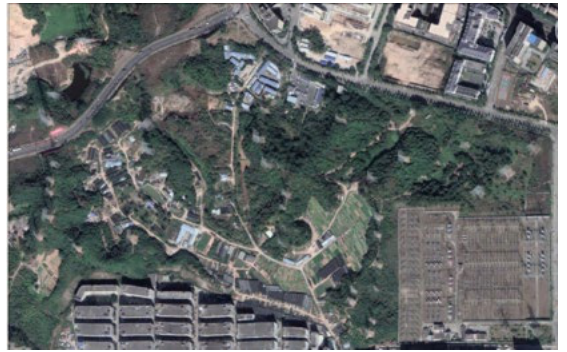
Figure 4. Test site shown in Google Earth The tower has three cross arms, where two transmission lines are combined at each end so that the power line consisting of 12 wires placed at 3 levels, shown in Figure 5.